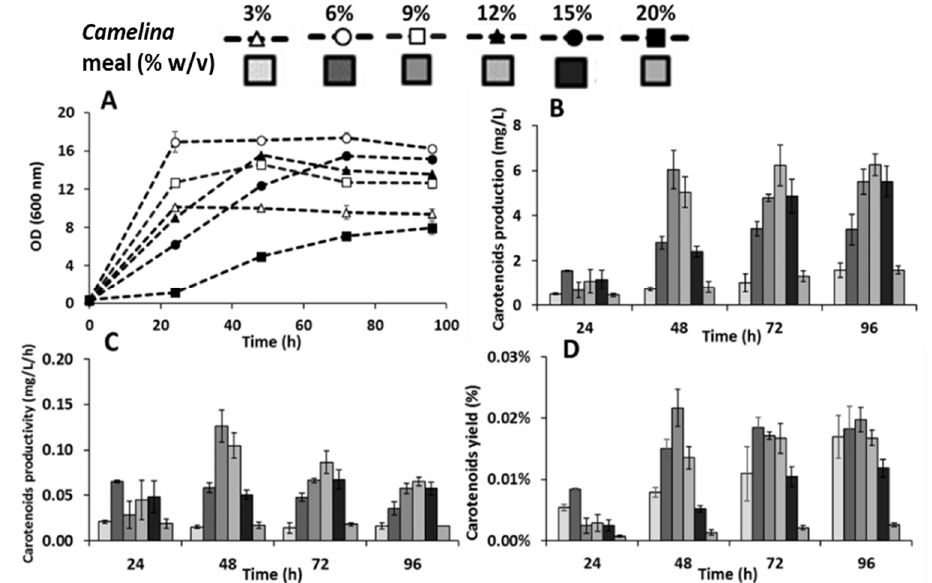
Figure 2. Production of carotenoids from different titers of Camelina meal. Modulation of solid loading of Camelina meal (from 3% to 20% w / v , hydrolysed with NS22119 11.9% w / w biomass ) and its effect on R. toruloides growth and carotenoids production. Growth in terms of OD (panel A ), and carotenoids production in terms of titer (panel B ), productivity (panel C ), and yield (panel D ) are given.